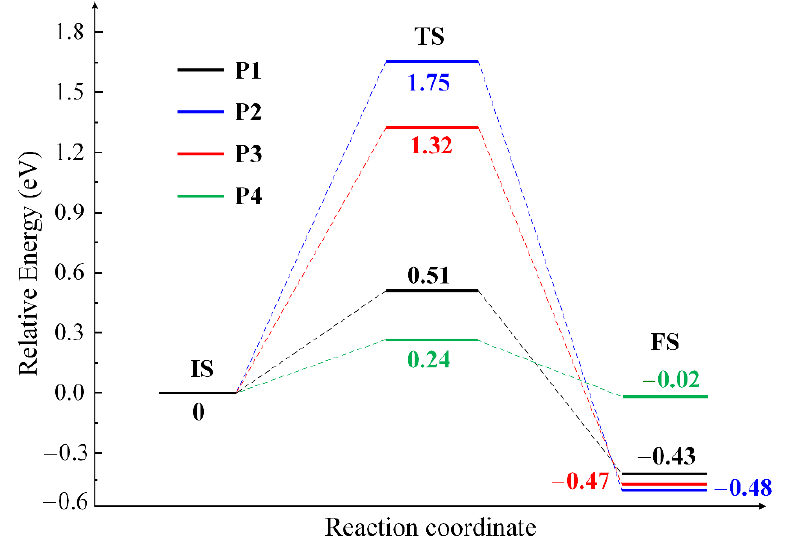
Figure 7. Potential energy diagram for the O anion diffusion processes in different pathways on the CuO(110) surface of O-terminated.